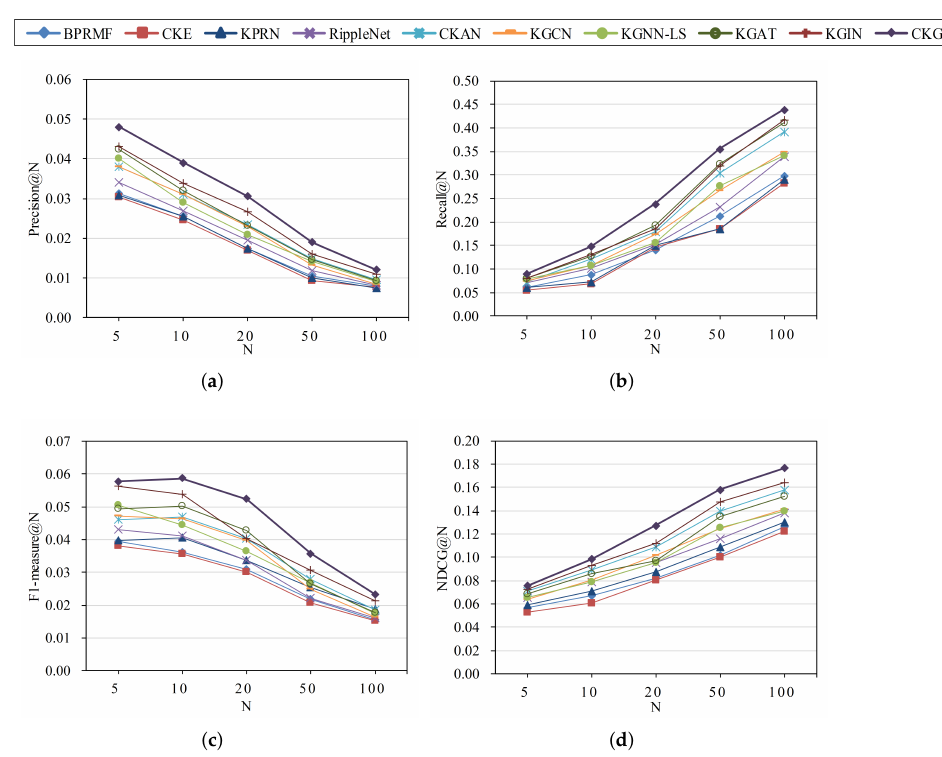
Figure 3. Top-N recommendation performance comparison on the Last.FM dataset. ( a ) Precesion@N;